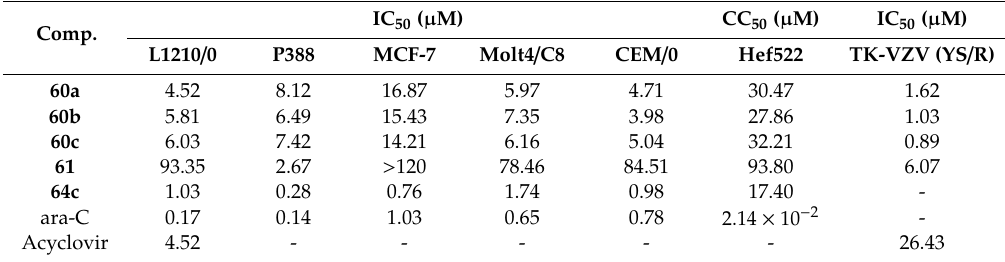
Table 25. The inhibitory activity of purine and butenolide conjugates toward Escherichia coli ribonucleotide diphosphate reductase (RDPR) enzyme.